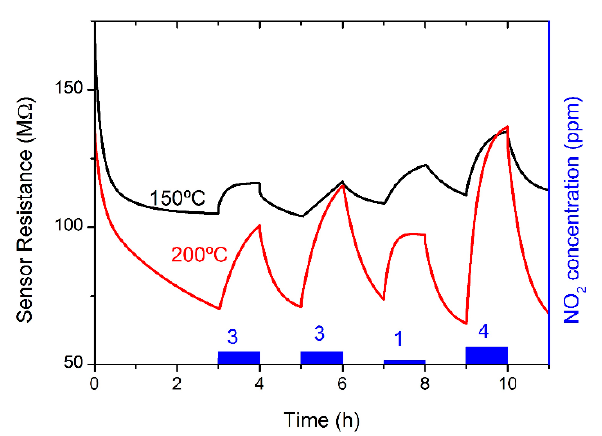
Figure 12. Sensor resistance of a single NW from Sample A for nitrogen dioxide consecutive pulses of different concentrations at two operation temperatures.